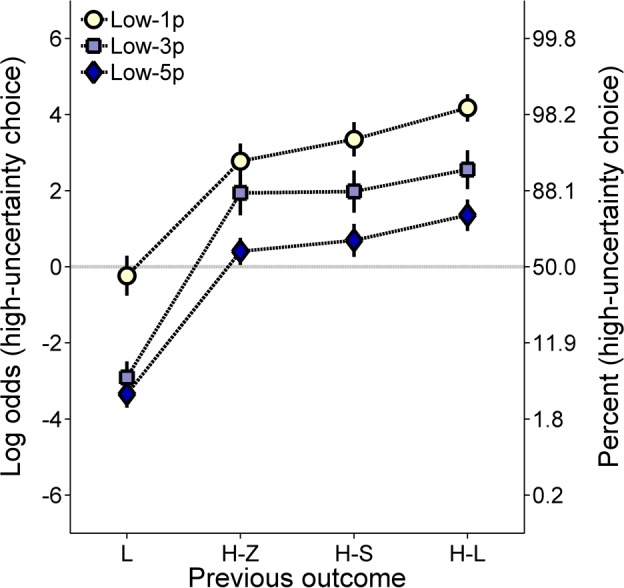
Mean (±SEM) log odds of high-uncertainty choices in the low-uncertainty magnitude training procedure of Experiment 3B as a function of the outcome of the previous choice and the outcome magnitude (pellets, p) of a low-uncertainty outcome choice.A second ordinate showing percentages corresponding to the log odds values is included to aid interpretation.